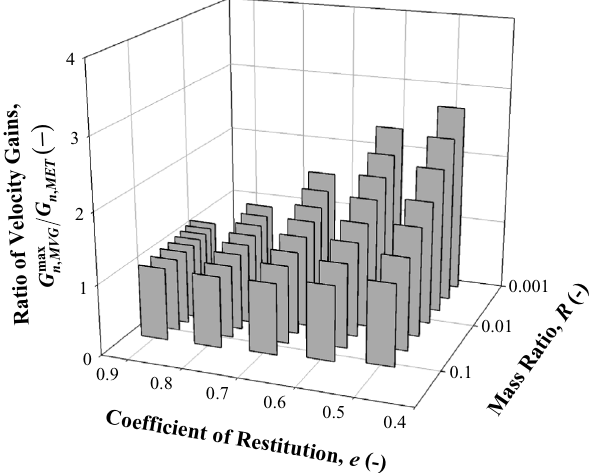
Fig. 13. 3D plot of ratio (MVG/MET) of velocity gains versus coefficient of restitution and mass ratio. The velocity gain for the MVG system is that of the optimal MVG system for the given R,e . (-) means non-dimensional.